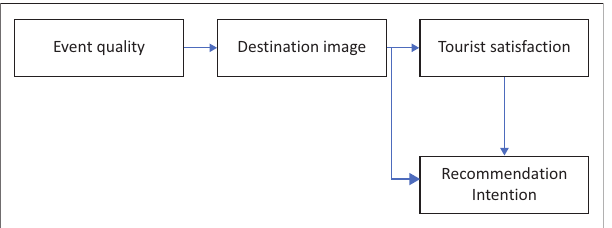
FIGURE 1: The proposed research